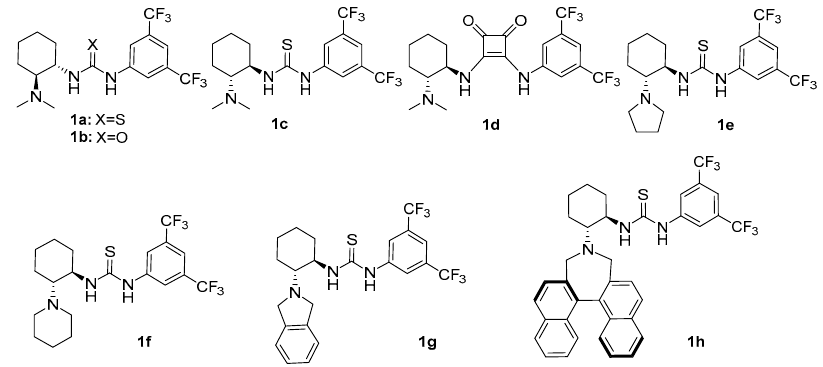
Figure 1. (Thio)urea derivatives screened as organocatalysts ( 1a – 1h ).